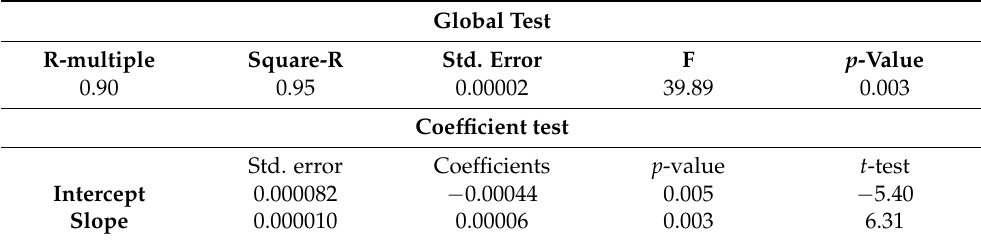
Table 3. Parameters for the global (F-test) and individual coefficient ( t -test) for linear regression at a significance level α =